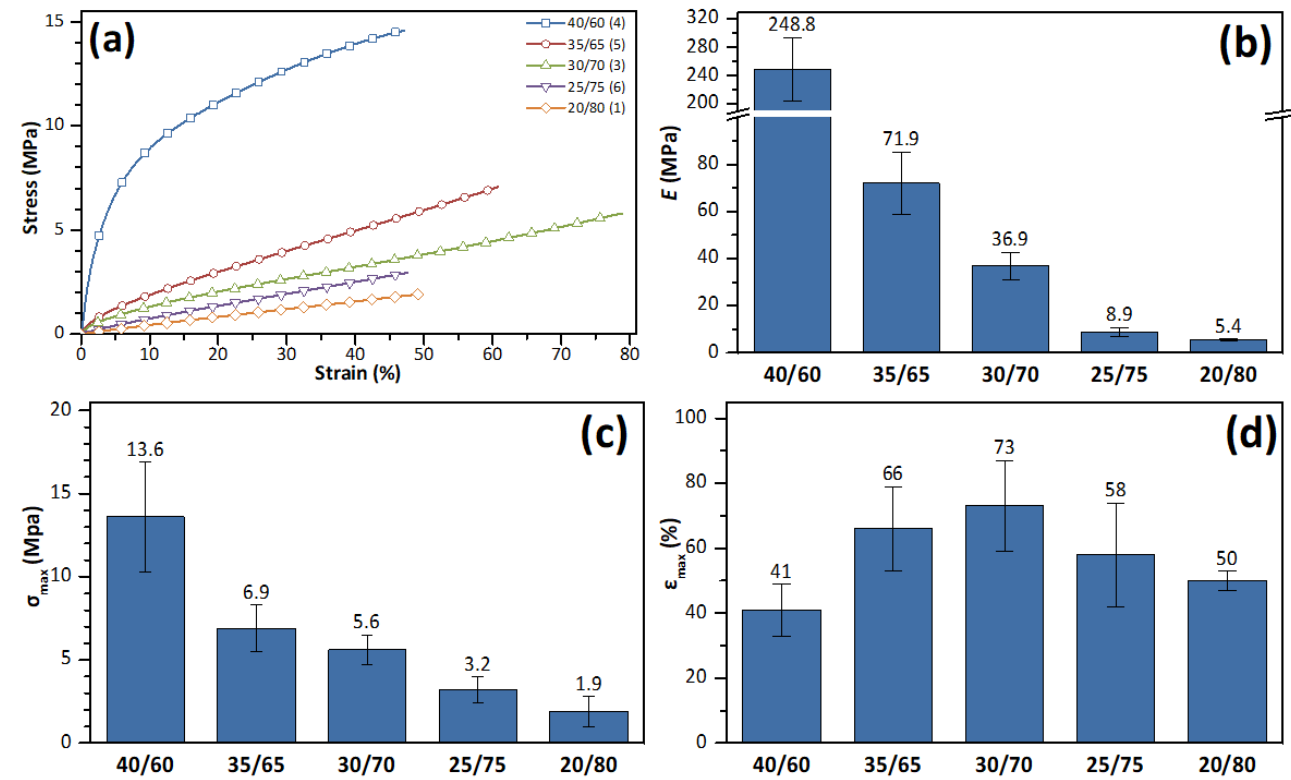
Figure 5. Stress – strain curves ( a ), tensile modulus ( E , ( b )), maximum tensile strength ( σ max , ( c )), and maximum elongation ( ε max , ( d )) of the photo-cured samples based on UrDMA/UrA mixtures containing TPOL (1 wt.%).